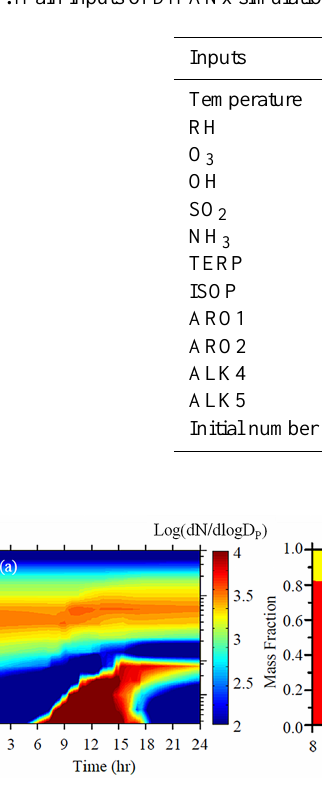
Figure 1. (a) Predicted aerosol dry size distribution for a typical spring nucleation event at Hyytiälä without condensation of organ- ics. Particle number concentration is plotted against local time of day ( x axis) and particle diameter ( y axis). (b) Predicted composi- tion of new particles.